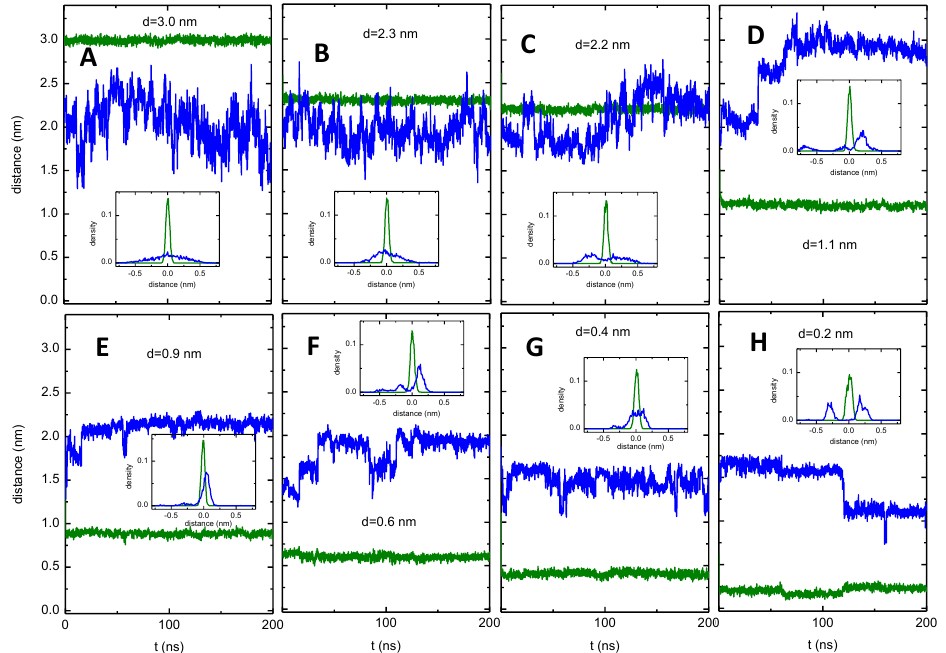
Figure 7. Transverse location of the NBD group of NBD – C4 ( z , — ) and radial distance to the TM COM of P – gp ( d , — ) as a function of the simulation time in the windows corresponding to a restrained distance to the TM COM of P – gp ( d = 3 nm ( A ), in the lipid bilayer; d = 2.2 and 2.3 nm ( B , C ), approaching the P – gp outer surface; d = 1.1 nm and 0.9 nm ( D , E ), near P – gp ’s entry gate; and d = 0.6, 0.4 and 0.2 nm ( F , G , H ), inside the P – gp binding pocket). The insets show the density of the NBD group around its average position in each window relative to the transverse (z, — ) and to the constrained radial ( d , — ) distance.